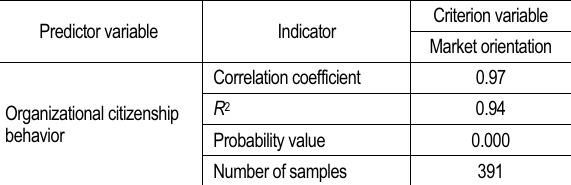
Table 3. The relationship between organizational